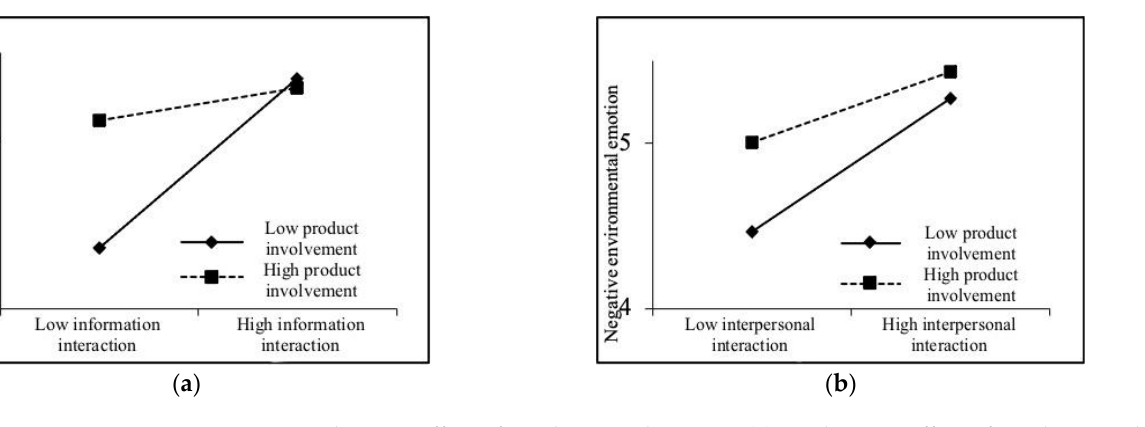
Figure 3. Moderating effect of product involvement. ( a ) Moderating effect of product involvement on the path “green information interaction—negative environmental emotion”. ( b ) Moderating effect of product involvement on the path “green interpersonal interaction— negative environmental emotion”.